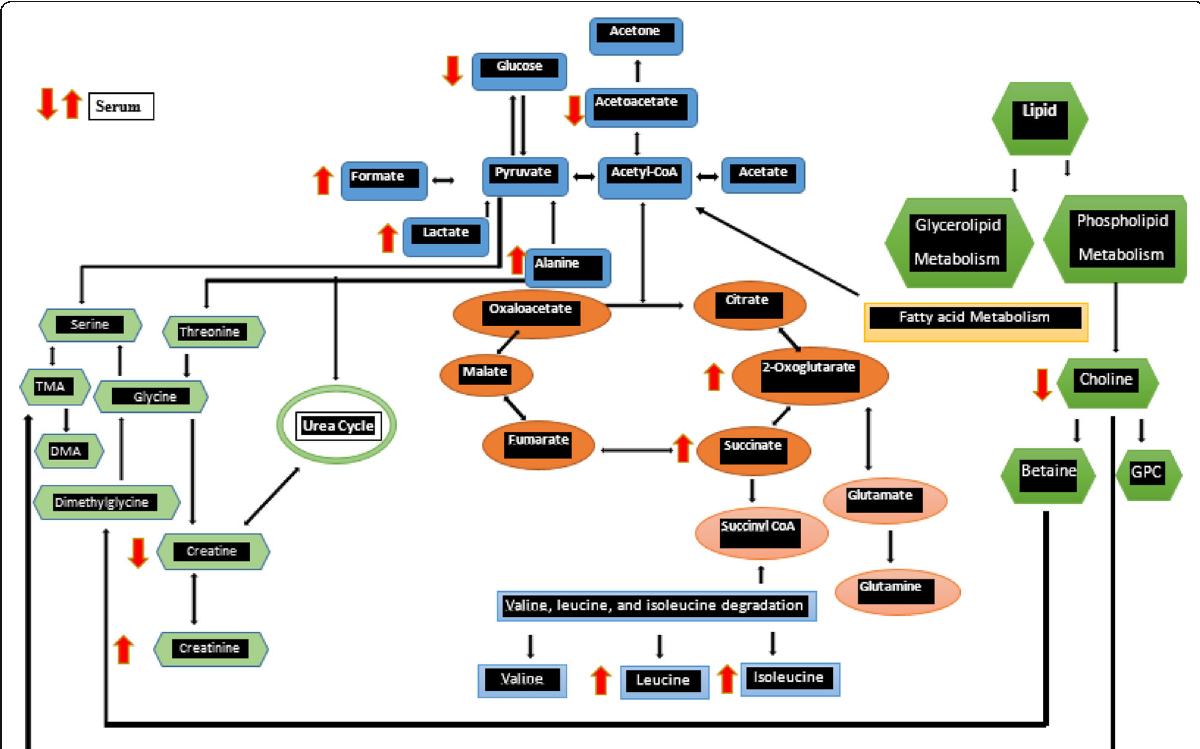
Fig. 11 Metabolism pathways describing regulation of potential urine and serum biomarkers upon ML extract